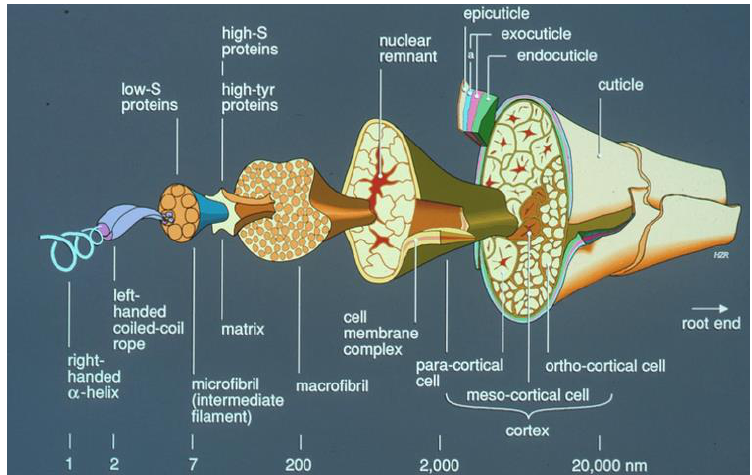
Figure 1. Schematic diagram of wool fibre structure [37] (2020, https://www.hdwool.com/blog/the- structure-of-wool).